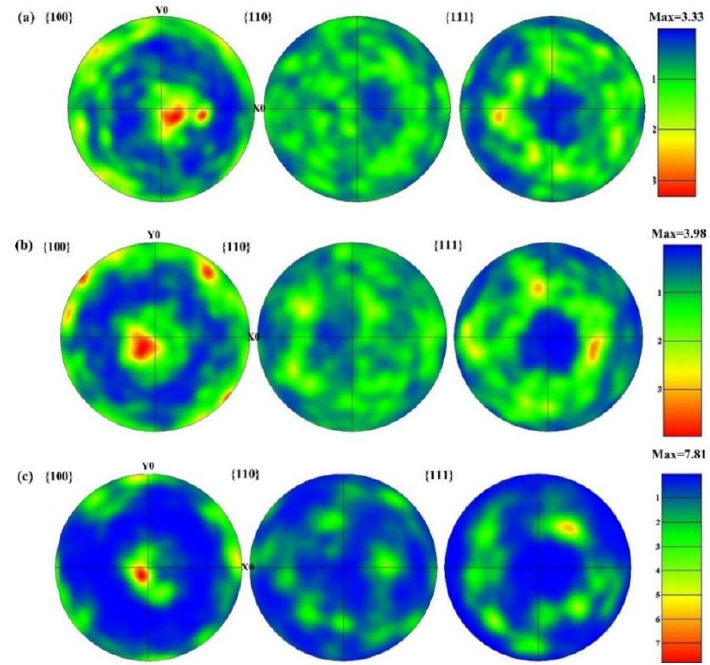
Figure 8. Pole figure (PF) under different VEDs: ( a ) VED = 60 J·mm −3 ; ( b ) VED = 96 J·mm −3 ; ( c ) VED = 119 J·mm −3 .